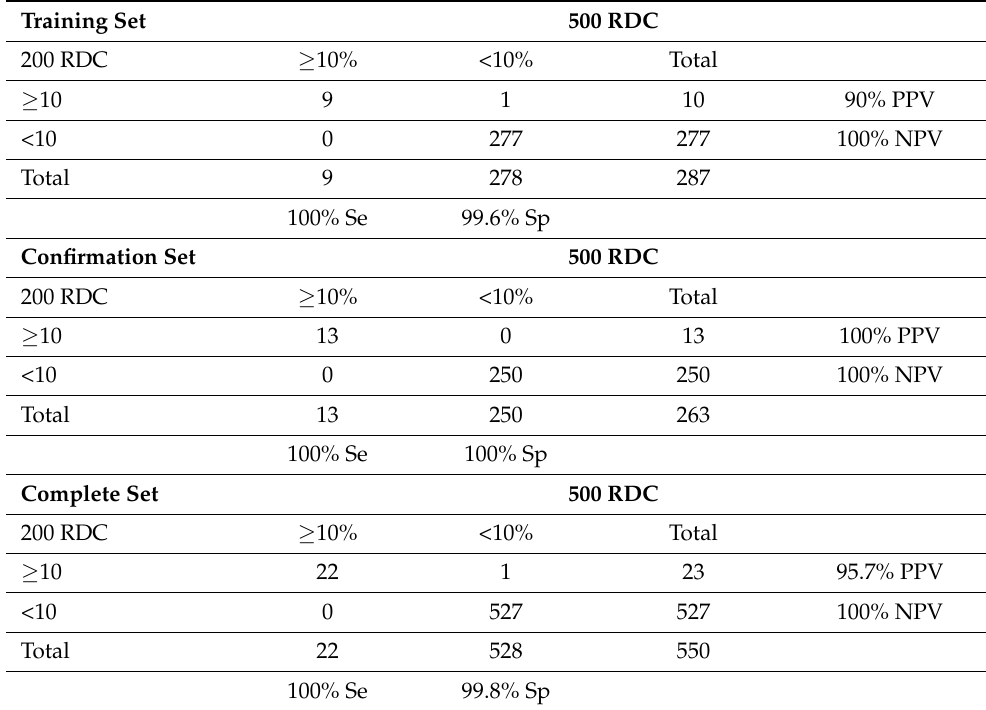
Table 7. Diagnostic performance of 200-cell DCC at the 10% blast cutoff.